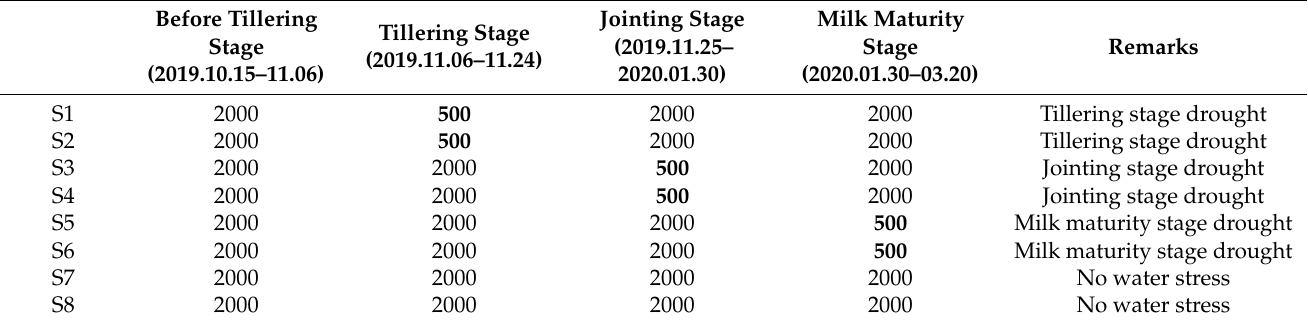
Table 1. The amount of irrigation once a week per time for different sets (unit: mL). Date format